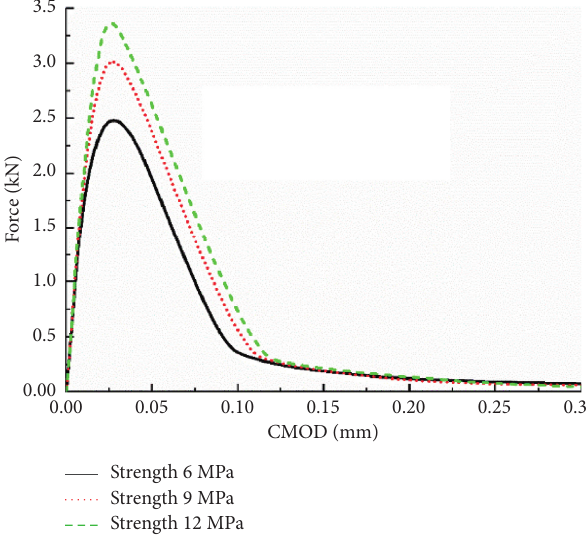
Figure 15: Effect of cohesive strength on the P-CMOD curve.